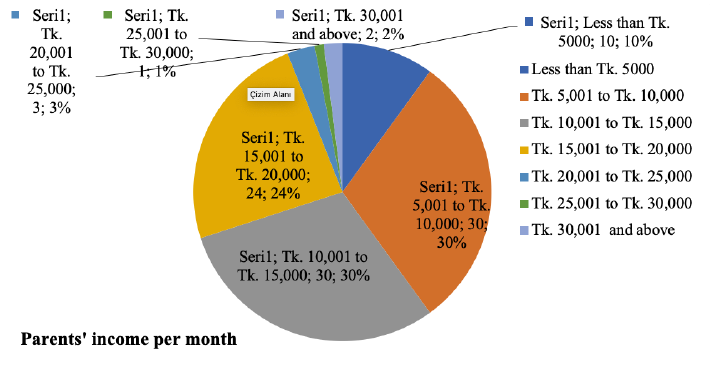
Figure 5: Parents' income per month